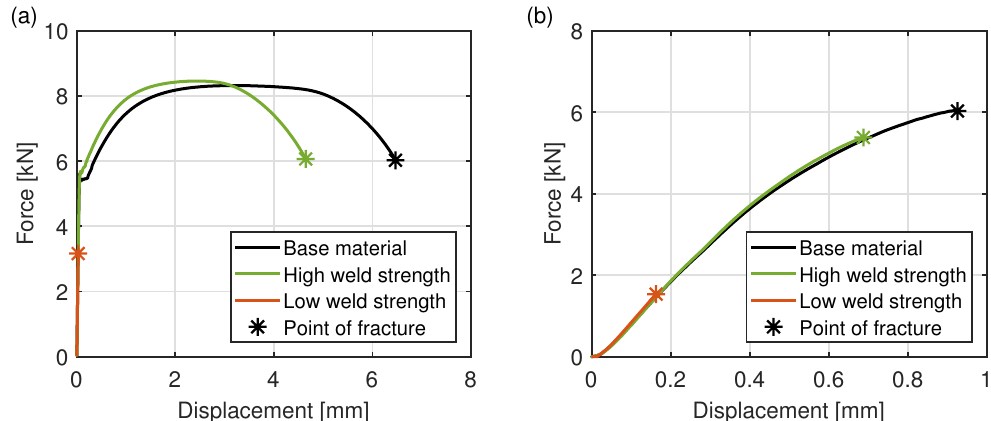
Figure 8. Force-displacement curves of the base material and of the welded specimens with high and low weld strength in the ( a ) tensile test and ( b ) bending